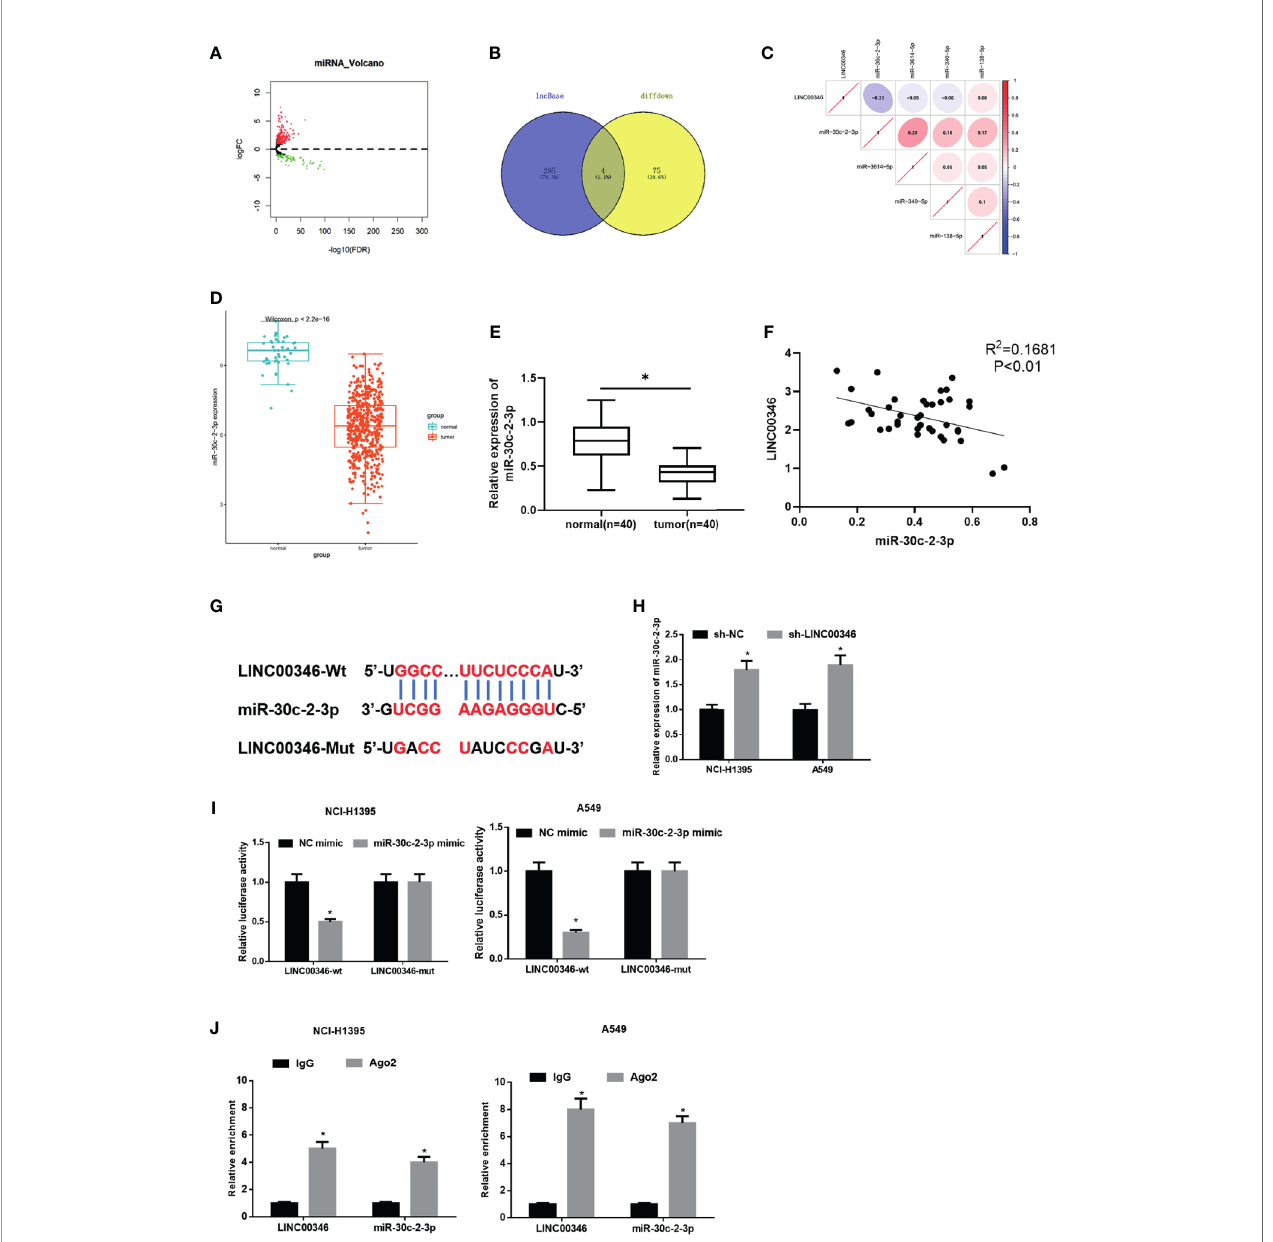
FIGURE 3 | LINC00346 acts as a molecular sponge of miR-30c-2-3p. (A) Volcano plot of DEmiRNAs in TCGA-LUAD dataset; (B) The Venn diagram of predicted downstream miRNAs and down-regulated DEmiRNAs; (C) Pearson correlation analysis of LINC00346 and miR-30c-2-3p; (D) The expression of miR-30c-2-3p in TCGA-LUAD (green represents the normal samples and the red represents the tumor samples); (E) qRT-PCR was used to detect the expression of miR-30c-2-3p in 40 pairs of clinical samples; (F) Correlation analysis indicates a negative correlation between LINC00346 and miR-30c-2-3p expression in 40 LUAD tissue samples; (G) The targeted binding sequence of LINC00346 and miR-30c-2-3p was predicted by lncBase database; (H) Expression level of miR-30c-2-3p in NCI-H1395 cells and A549 cells after transfection with sh-LINC00346; (I) Dual-luciferase reporter assay veri fi ed the targeted binding relationship between miR-30c-2-3p and LINC00346 in LUAD cells; (J) The enrichment of miR-30c-2-3p and LINC00346 in Ago2 immunoprecipitation was detected by RIP. * P <